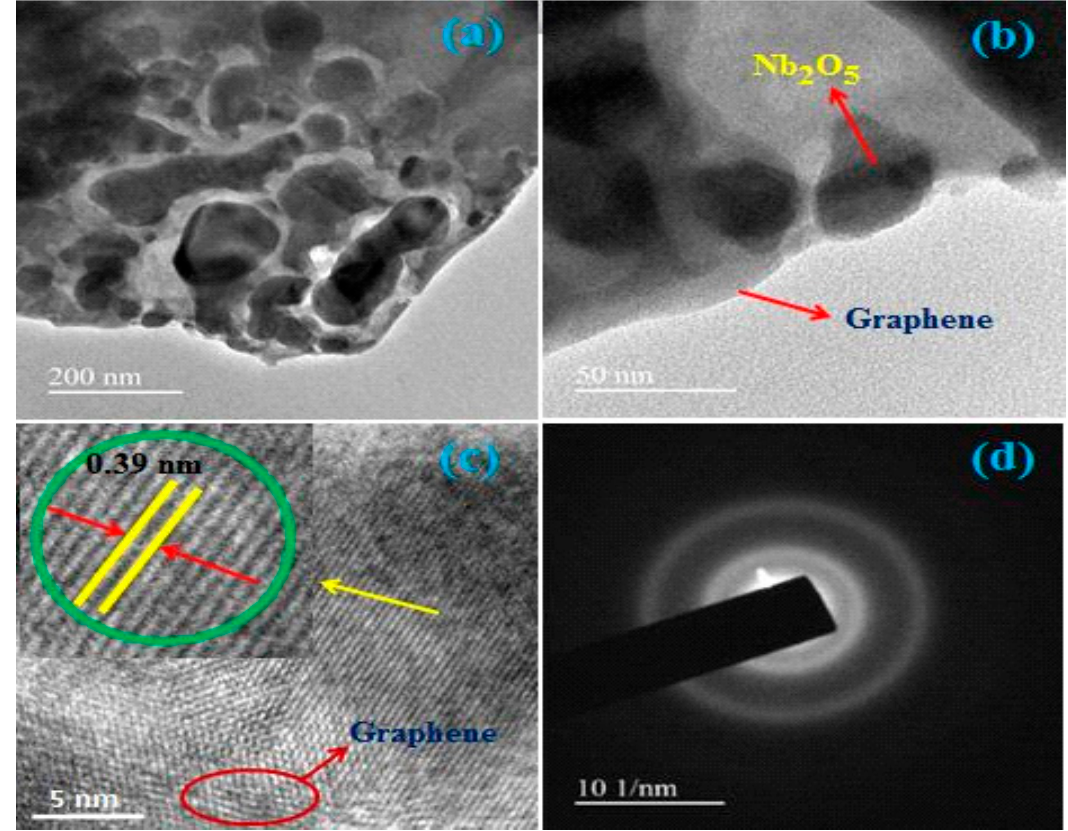
Figure 2. ( a , b ) Morphology of Nb 2 O 5 /G nanocomposite annealed at 600 °C.